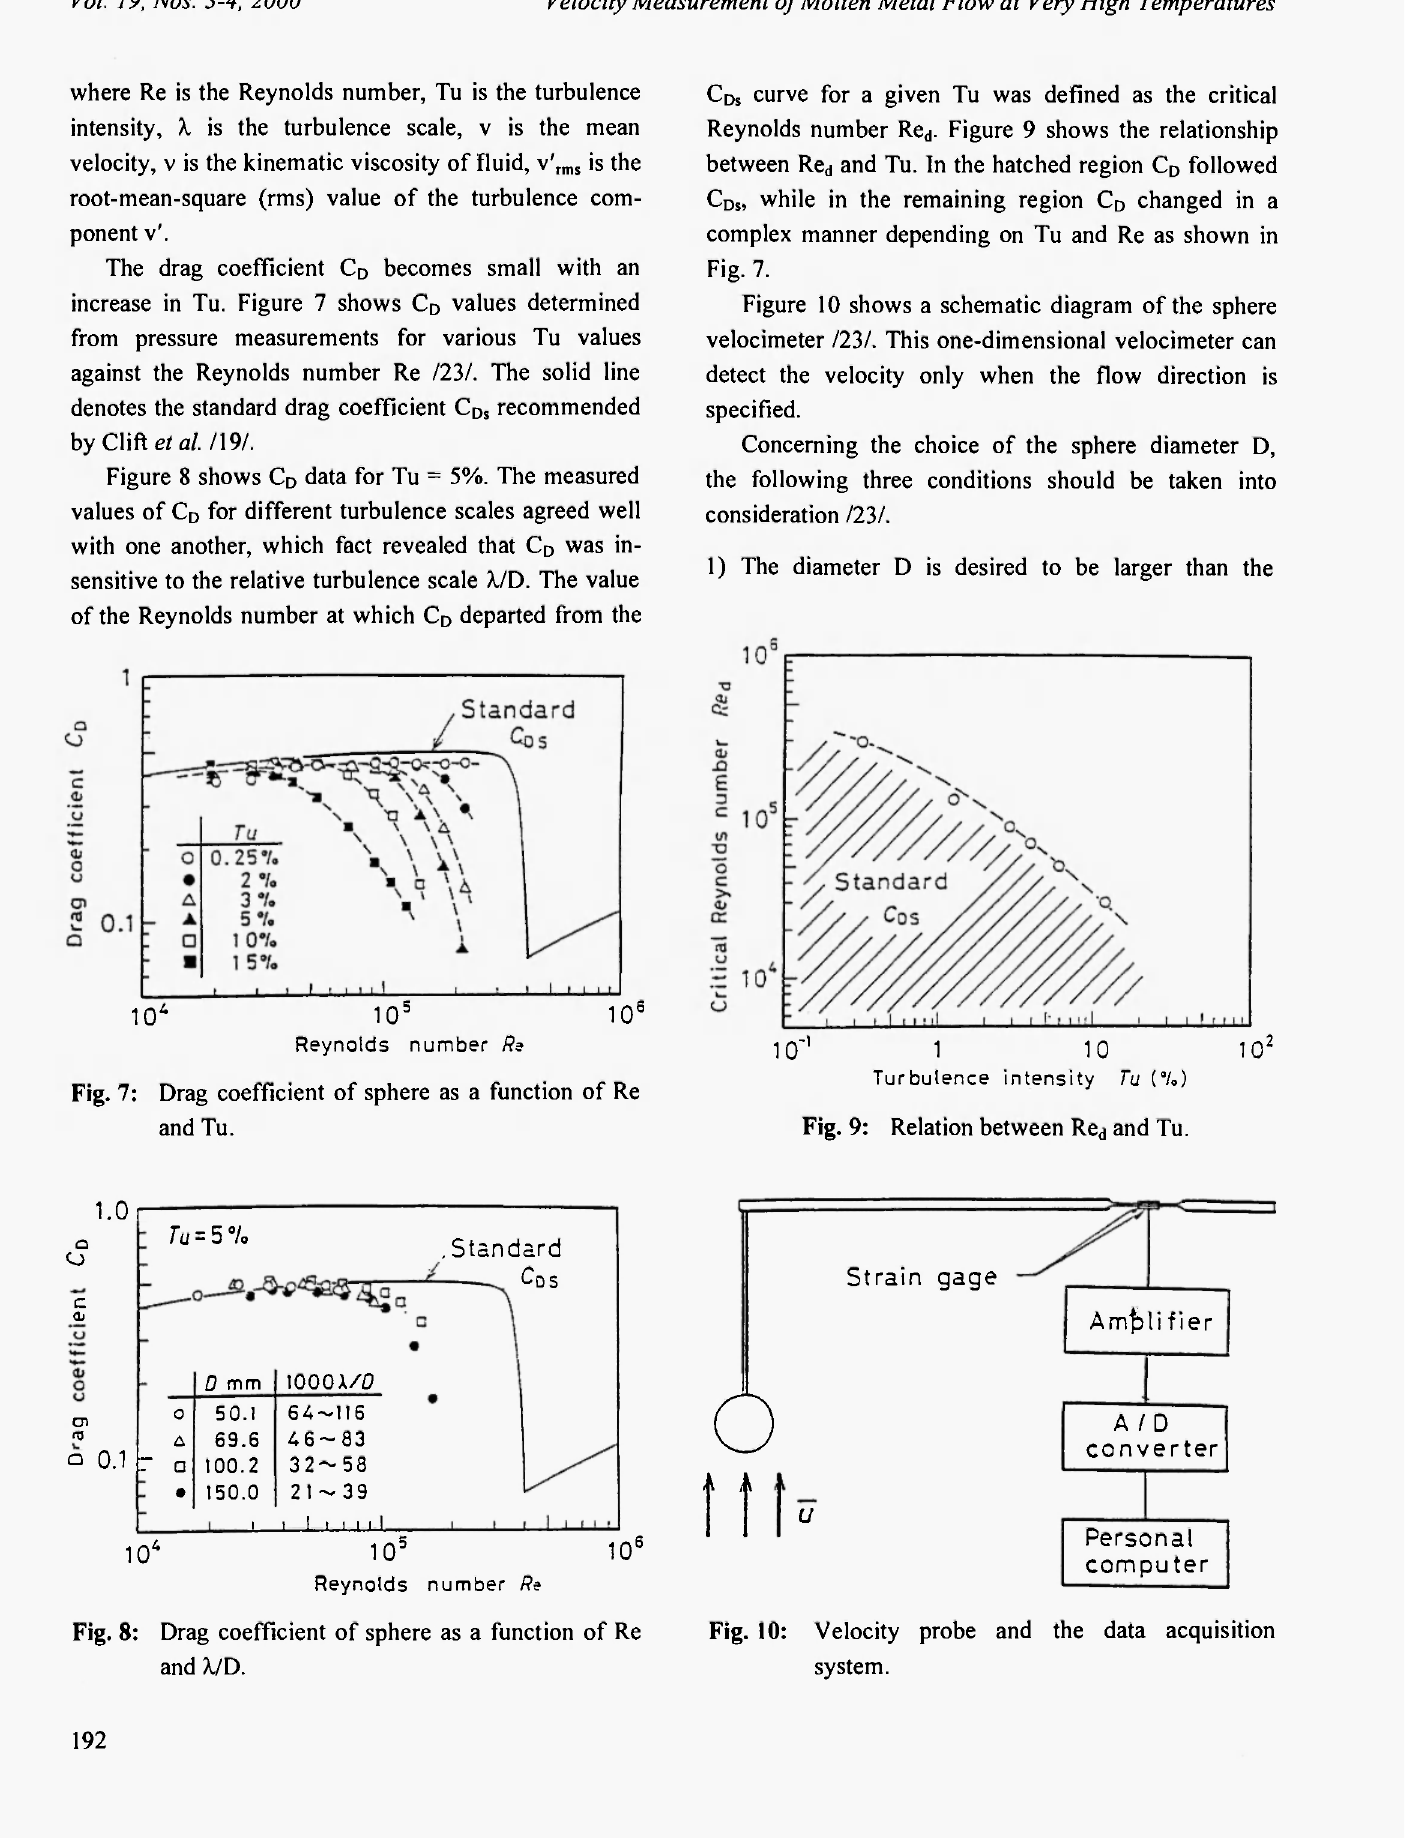
Fig. 8: Drag coefficient of sphere as a function of Re and λ/D.